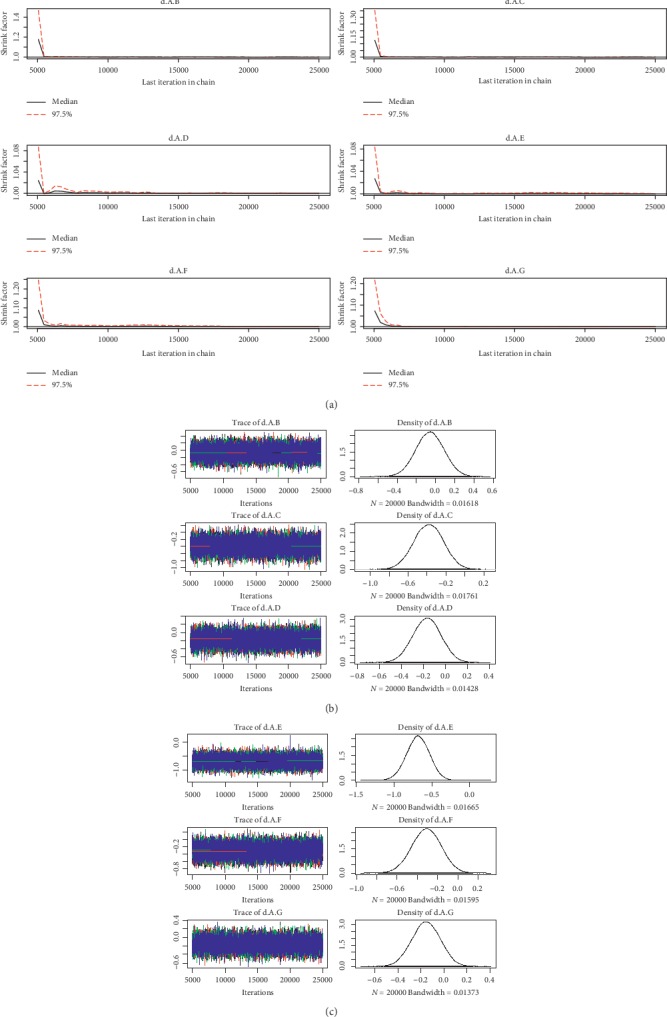
Brooks-Gelman-Rubin diagnostic plot and density plot for the efficacy of the comparison among different treatments of patients with mild renal function.